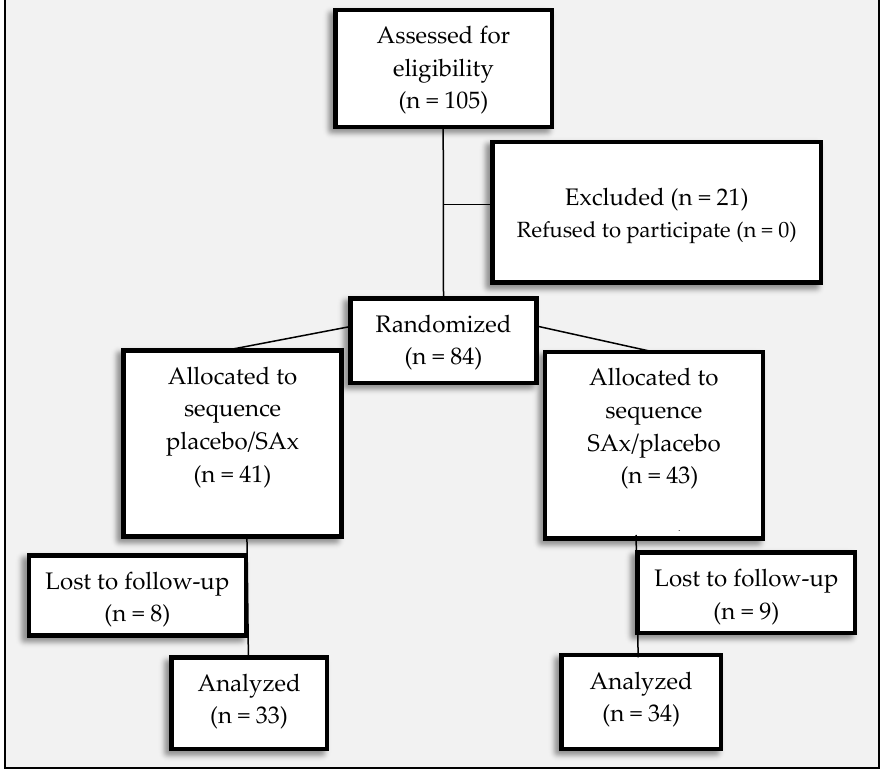
Figure 1 . Flow chart describing the present trial. Figure 1. Flow chart describing the present trial. Table 1. Baseline characteristics of the